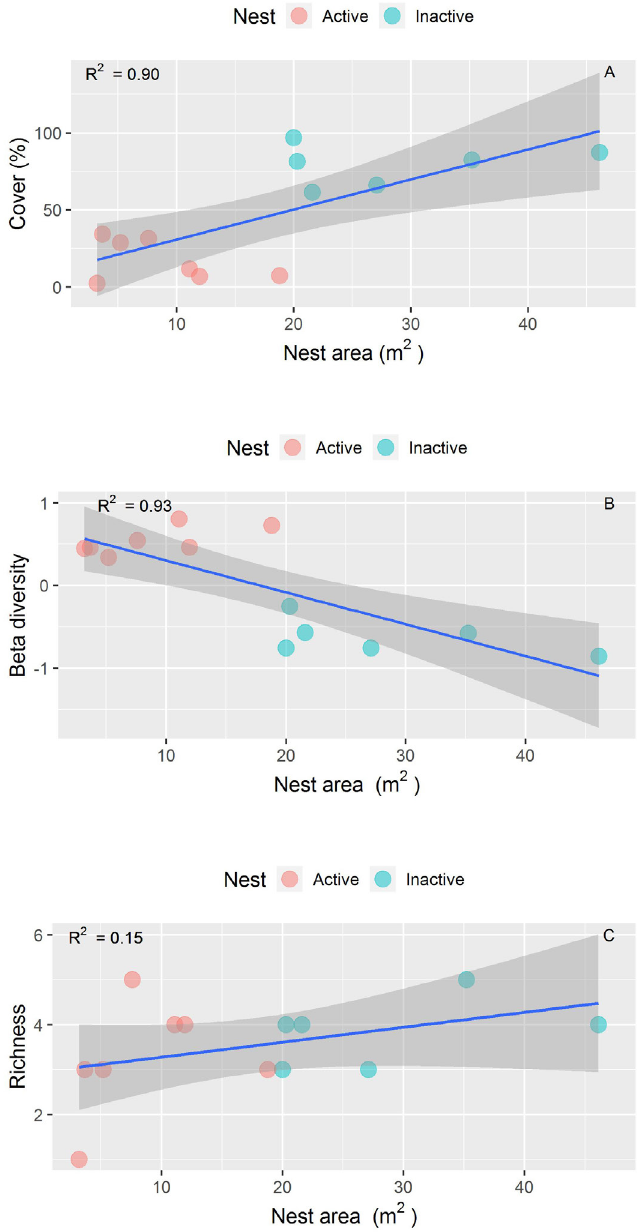
Figure 8. Relationships between the nest area and coverage (a), beta diversity (b), species richness (c) and nest groups (inactive and active). Solid lines represent fitted (predicted) values of the models, and the shaded polygons represent the 95 % associated with the modeled